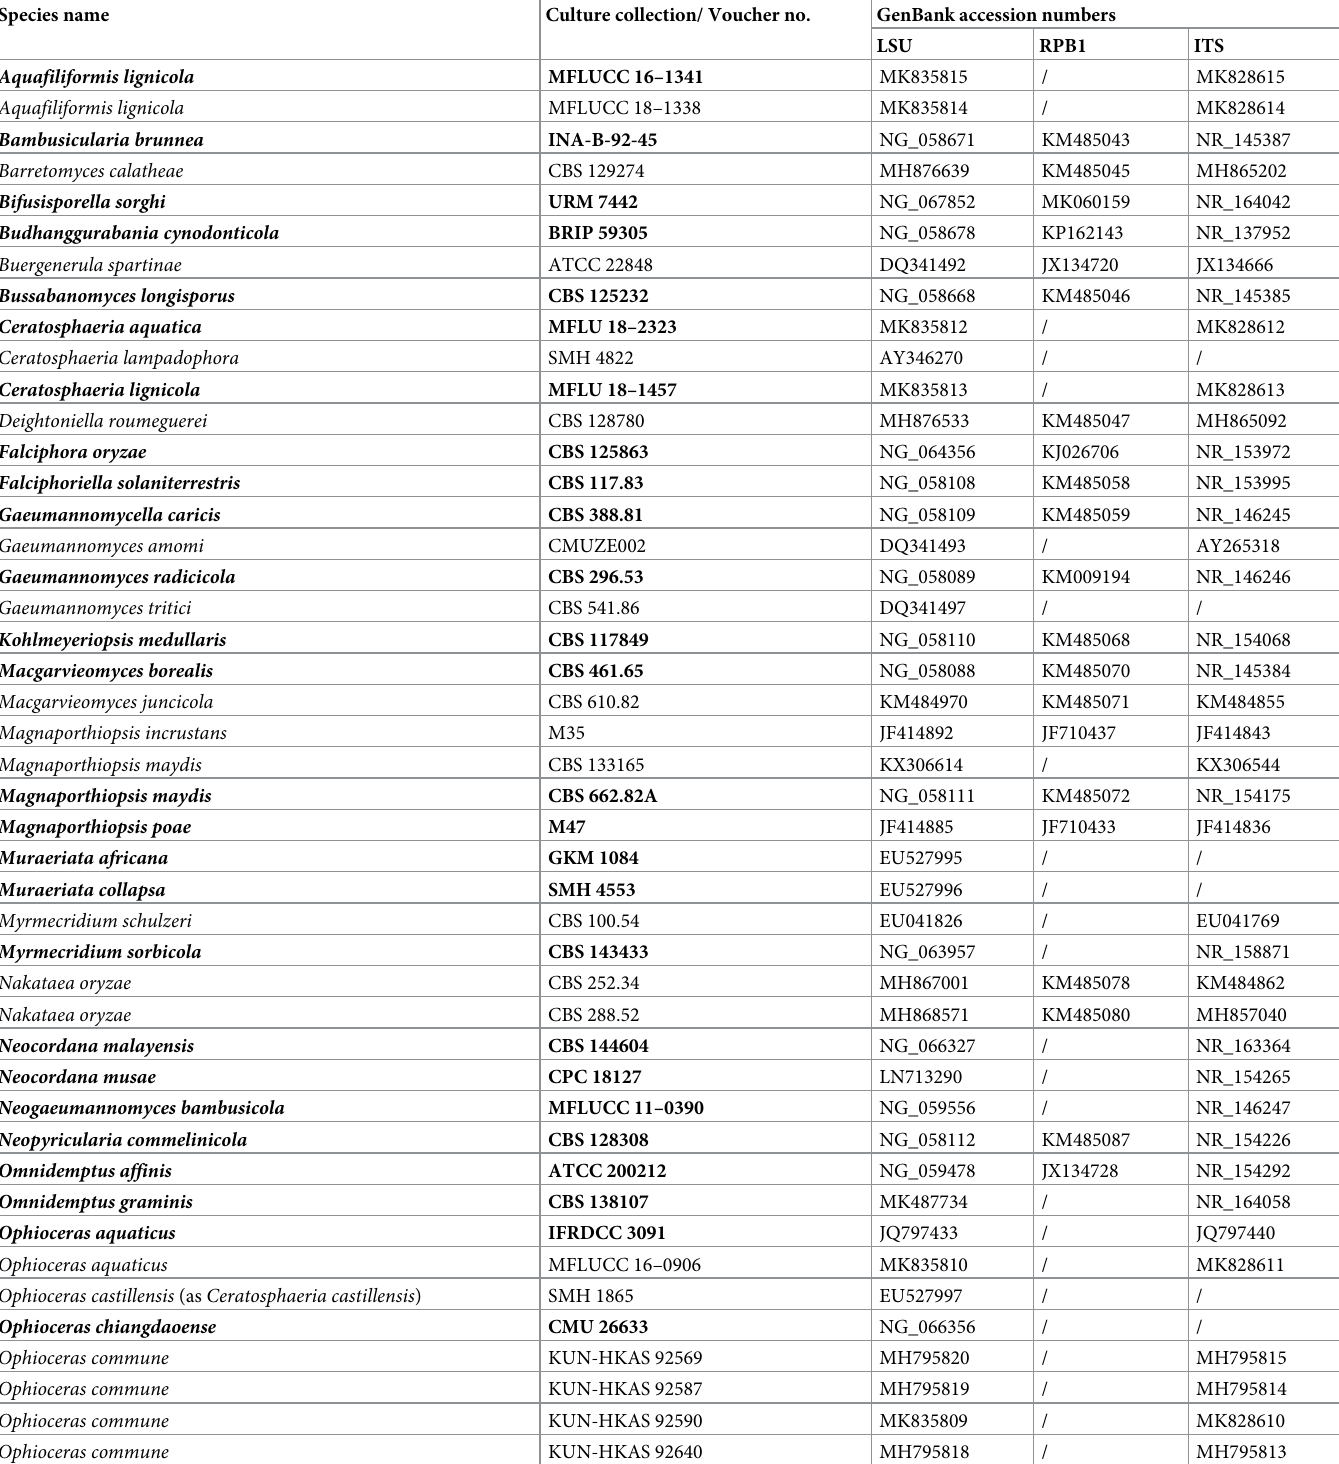
Table 1. Detailed information of fungal taxa used in the phylogenetic analyses. The newly generated sequences are indicated in blue , and the ex-type strains are in bold . Species